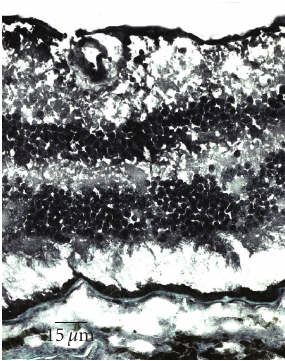
Figure 1: Microphotograph showing normal human retina stained for PPAR γ in the ganglion cell, inner nuclear layer, outer nuclear layer, and RPE (avidin-biotin-complex immunoperoxidase).